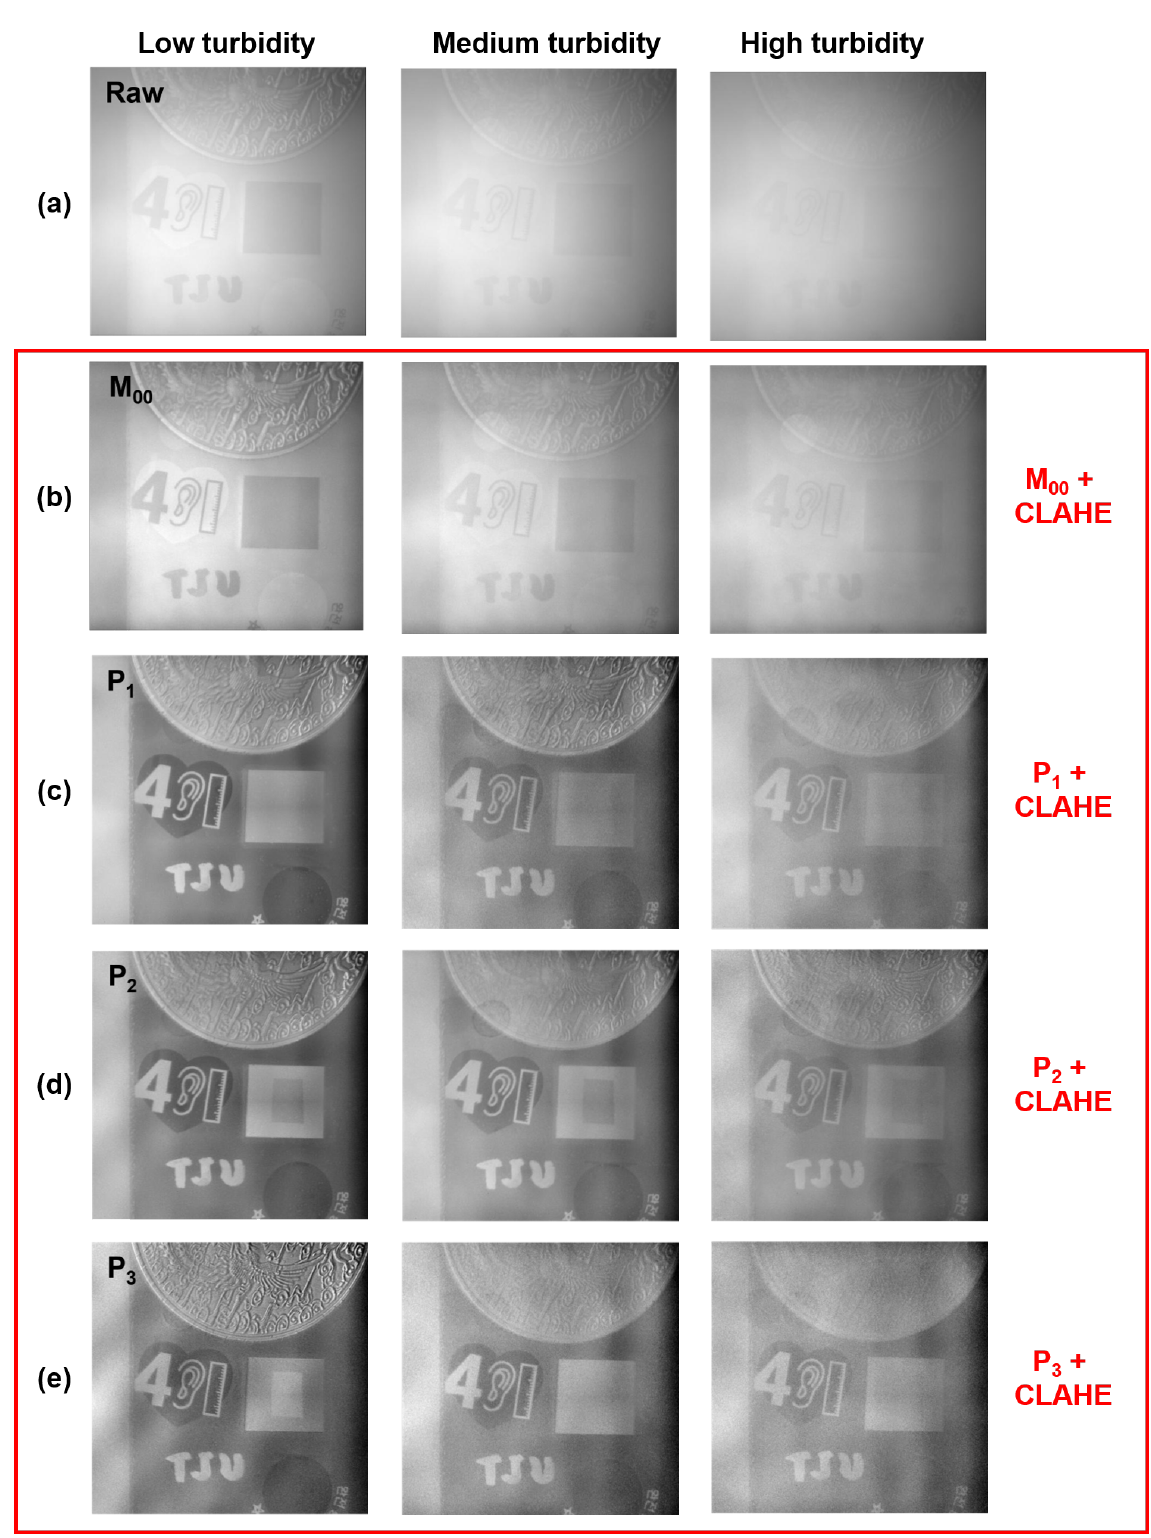
Figure 10. Comparison of different enhanced images: ( a ) raw intensity image; ( b ) enhanced raw intensity image, and ( c – e ) enhanced IPPs images via CLAHE